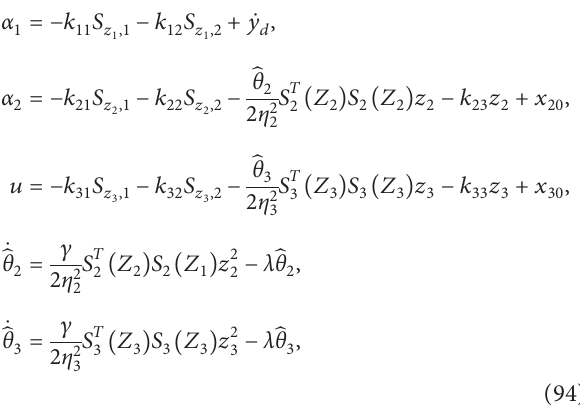
Figure 12: Tracking error y − y